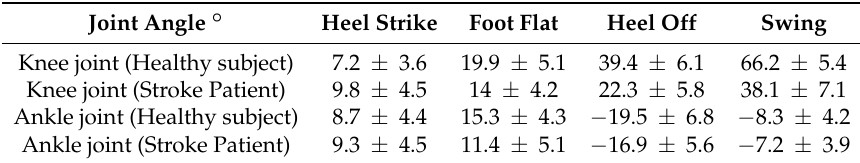
Table 5. Joint angle calculation results of a healthy subject and a typical stroke patient. Results are presented as mean ( ±